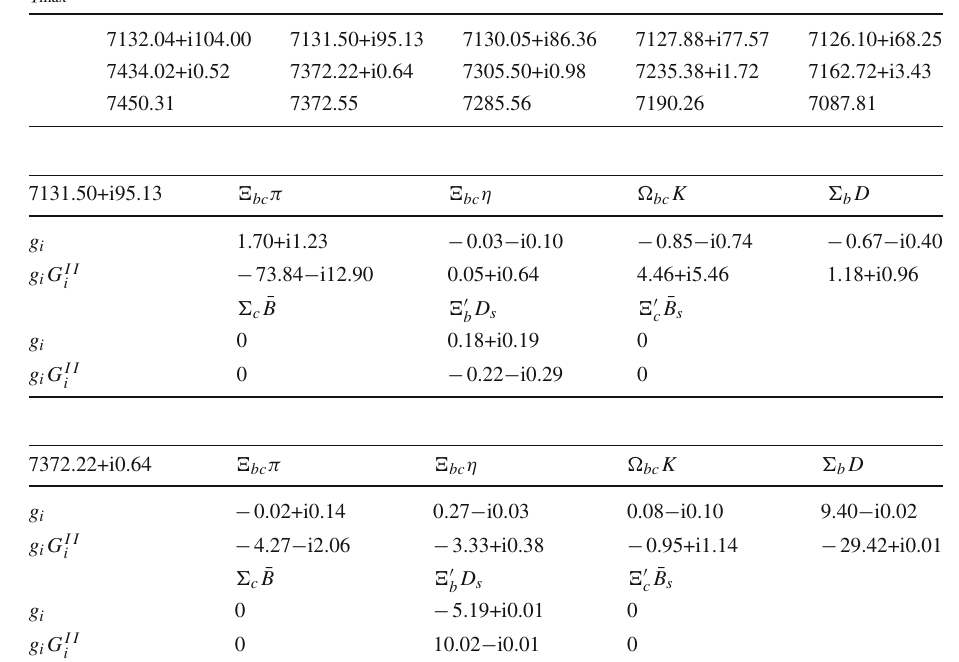
pesudoscalar-baryon (1/2) (MS) states (all units are in MeV)